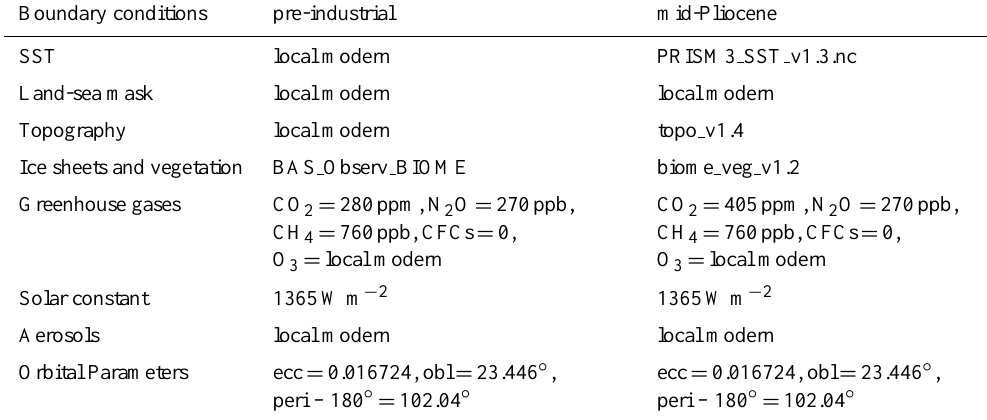
Table 1. Summary of the experimental design.